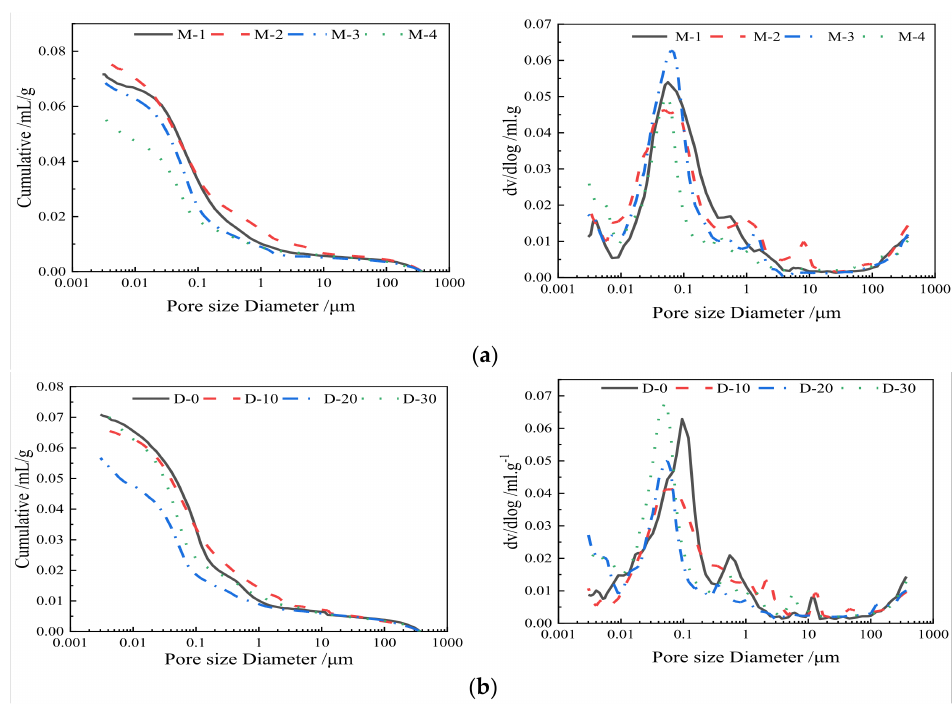
Figure 8. Pore size distributions in mortar samples at 28 days (mL/g). ( a ) Pore distribution curves under different systems; ( b ) Pore distribution curves under different cement replacement